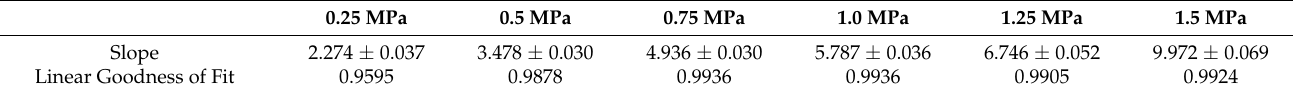
Figure 7. Phase differences in the transmitted radiations of the unload and loaded samples. ( a ) the phase-difference curve for the six loading environments. ( b ) phase-difference curve after linear fitting for the six loading environments. Table 2. Slope and linear goodness of linear